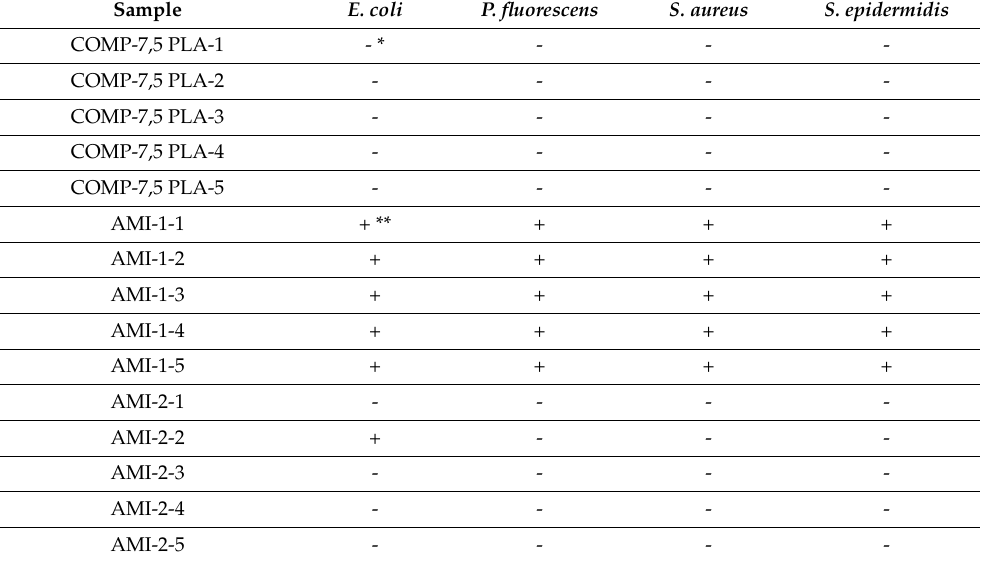
Table 2. Antibacterial activity tests